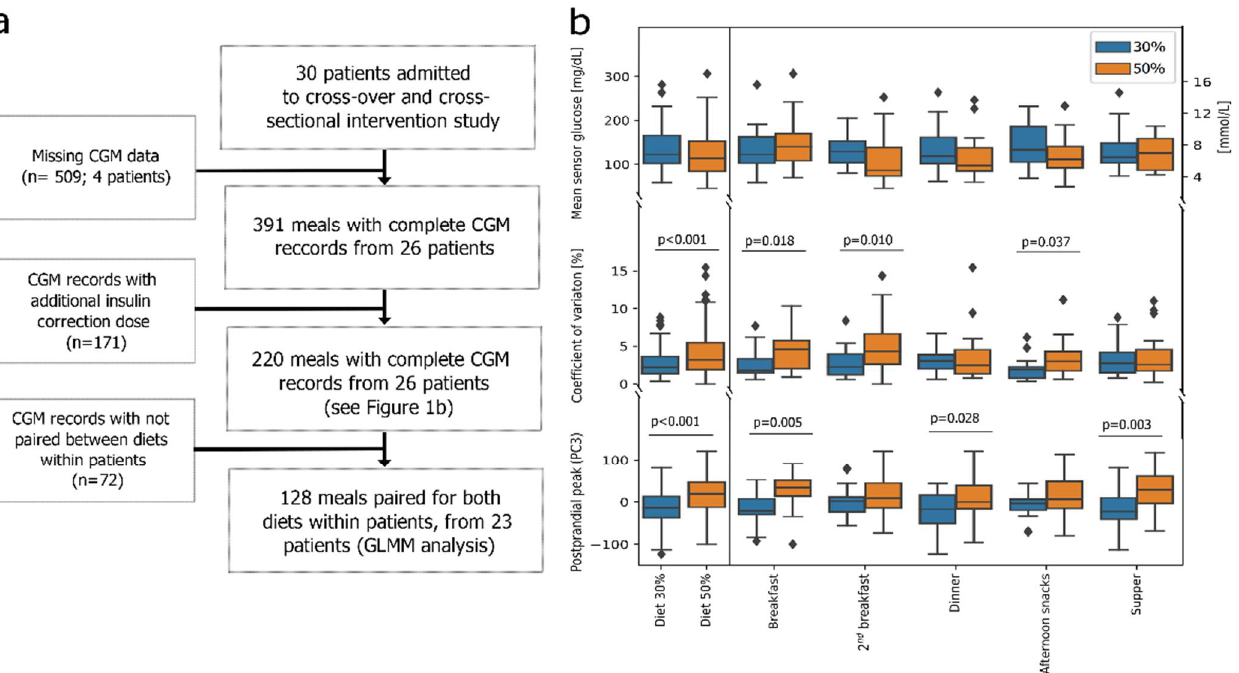
Figure 1. ( a ) Study flowchart; ( b ) Comparison of mean sensor glucose, coefficient of variation and postprandial peak between diets and meals for 220 observations. CGM—continuous glucose monitoring; GLMM—generalized linear mixed models; PC3—principal component 3 (see Figure S1). Outliers (>3SD) were marked with ◆ .